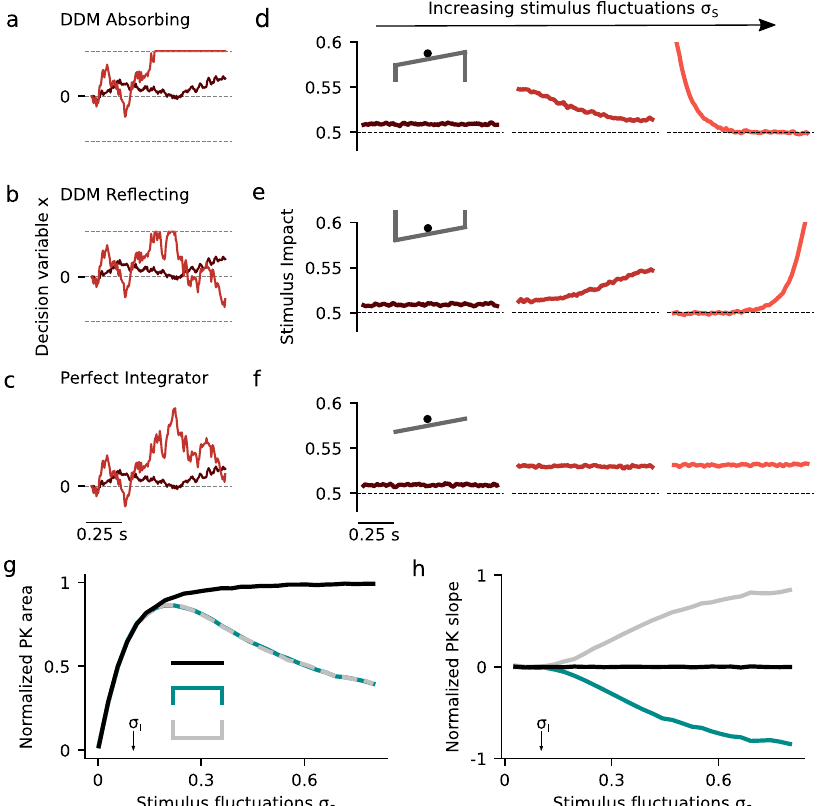
Fig. 1 Dynamics of evidence accumulation in the canonical drift diffusion models. a – c Single-trial example traces of the decision variable x(t) for weak ( σ S = 0.03) and intermediate ( σ S = 0.28) stimulus fl uctuations in the three canonical models. a The DDM with absorbing bounds integrates the stimulus until it reaches one of the absorbing bounds represented in the potential landscape as in fi nitely deep attractors (see inset in d ). The slope of the potential landscape is the mean stimulus strength, in this case μ < 0. b The DDM with re fl ecting bounds integrates the stimulus linearly until a bound is reached when no more evidence can be accumulated in favor of the corresponding choice option (see inset in e ). c The perfect integrator integrates the entire stimulus uniformly, corresponding to a diffusion process with a fl at potential (see inset in f ). In the three models, the choice is given by the sign of x(t) at stimulus offset. d – f Psychophysical Kernels (PK) for the three canonical models for increasing magnitude of the stimulus fl uctuations (from left to right): σ = 0.03, 0.28, and 0.69. The PK measures the time-resolved impact of the stimulus fl uctuations on choice (see Methods). g – h Normalized PK area and S normalized PK slope as a function of σ S for the three canonical models (see inset in g for color code). The area is normalized by the PK area of the perfect integrator with no internal noise ( σ i = 0) and hence measures the ability of each model to integrate the stimulus fl uctuations. In all panels, internal noise was fi xed at σ I = 0.1 (see arrows in g and h ) which was suf fi ciently small to prevent x(t) from reaching the bounds in the absence of a stimulus. Mean stimulus evidence was μ = 0 in all (Fig. 2a, inset). The three terms of the potential, from left to right, capture (1) the impact of the net stimulus evidence μ which,